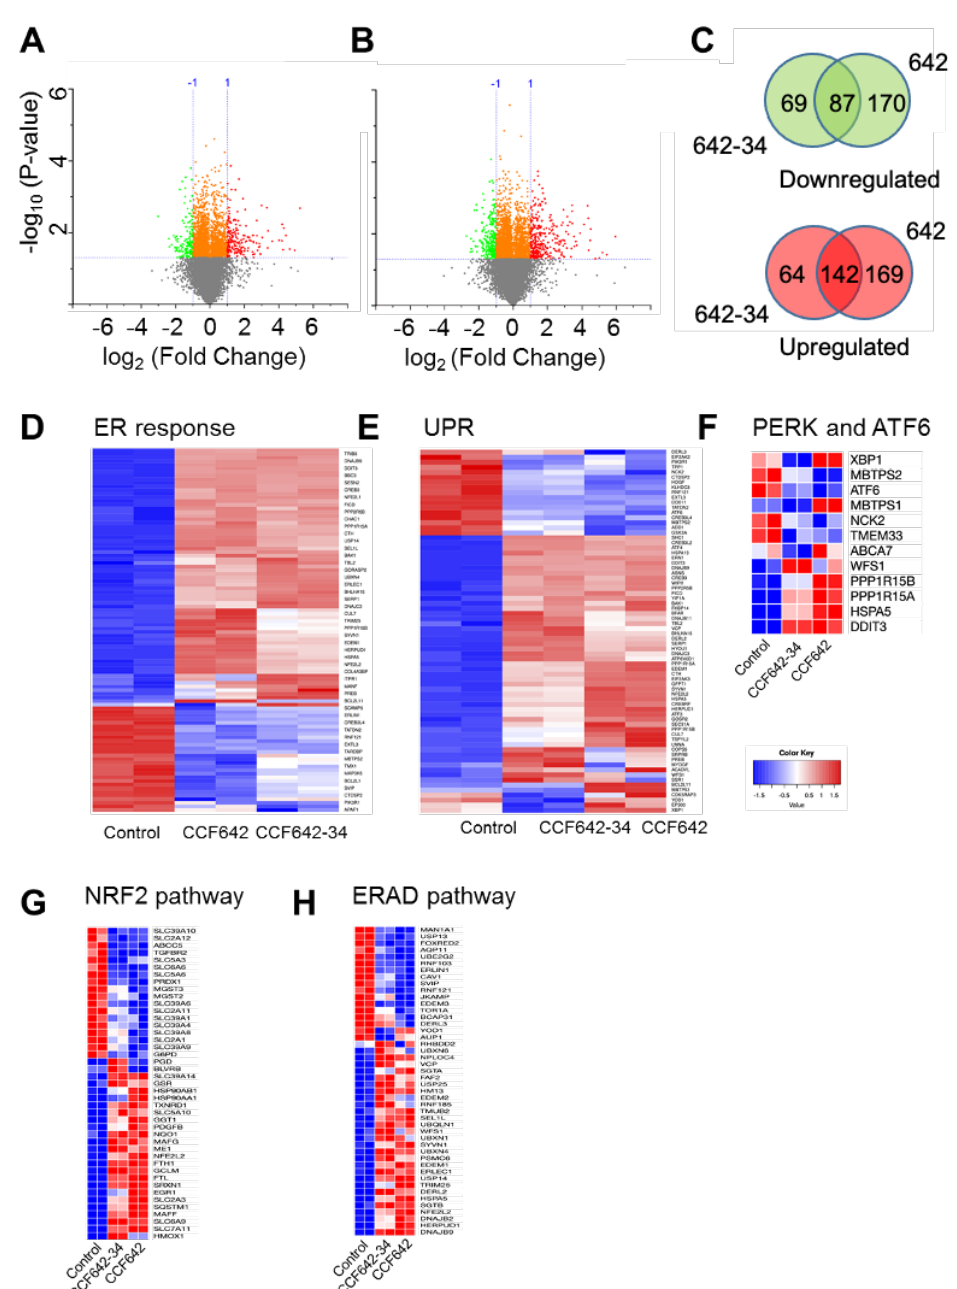
Figure 5. CCF642-34 is selective for PDIA1 inhibition-induced ER stress response pathway. MM1.S cells were treated with 3 µ M of either CCF642 or CCF642-34 for 6 h, and gene expression analysis was performed by RNA sequencing. ( A , B ) Volcano plots showing CCF642-34 and CCF642 compared to DMSO control. The criteria for differential